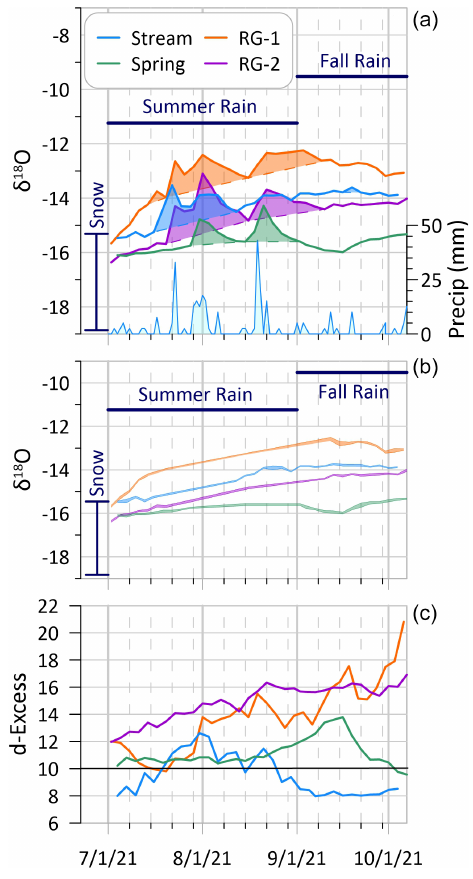
Figure 6. Time series from the 4 sampling sites. (a) Values of δ 18 O presented along with average values for snow and rain, and daily precipitation recorded at the Chepeta SNOTEL site (Fig. 1). (b) Same as panel (a) with transient spikes in δ 18 O due to precipita- tion events removed. Line width represents ± 1standard deviation. (c) Times series of d -excess. The reference value of 10‰ is high-